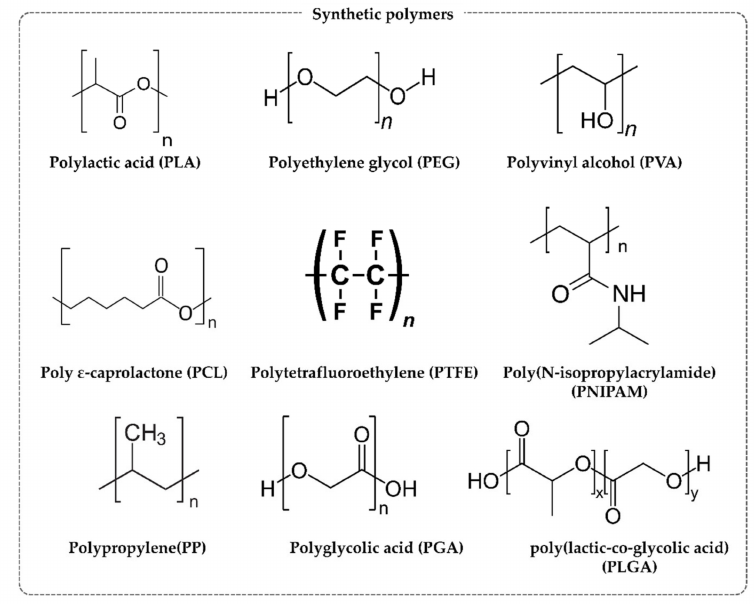
Figure 4. Structures of synthetic